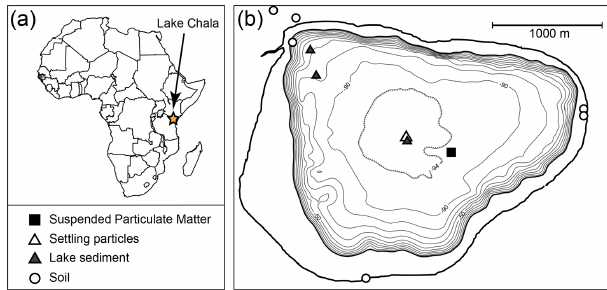
Figure 2. (a) Location of Lake Chala in East Africa, on the border of Kenya and Tanzania, and (b) the bathymetry of Lake Chala situ- ated within its steep-sided crater catchment (outer bold full line), with sampling locations of suspended particulate matter (SPM; black square), settling particles (sediment trap; open triangle), sur- ficial lake-bottom sediments (grey triangles) and terrestrial soils (open circles). Bathymetry adapted from Moernaut et al.